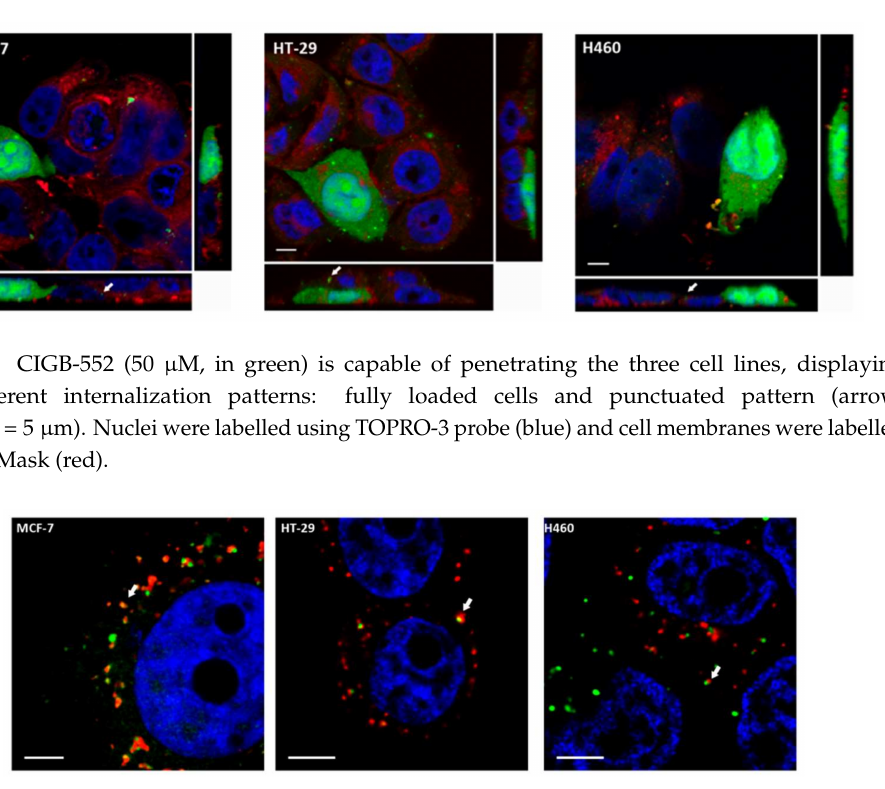
Figure 2. The punctuated pattern observed in CIGB-552 (green) internalization showed partial co-localization with Rab5A-RFP in red (arrow), which is an early endosomal marker, indicating that endocytosis might be one of the mechanism involved in CIGB-552 internalization (scale bar = 5 µ m). Nuclei were labelled using TOPRO-3 probe